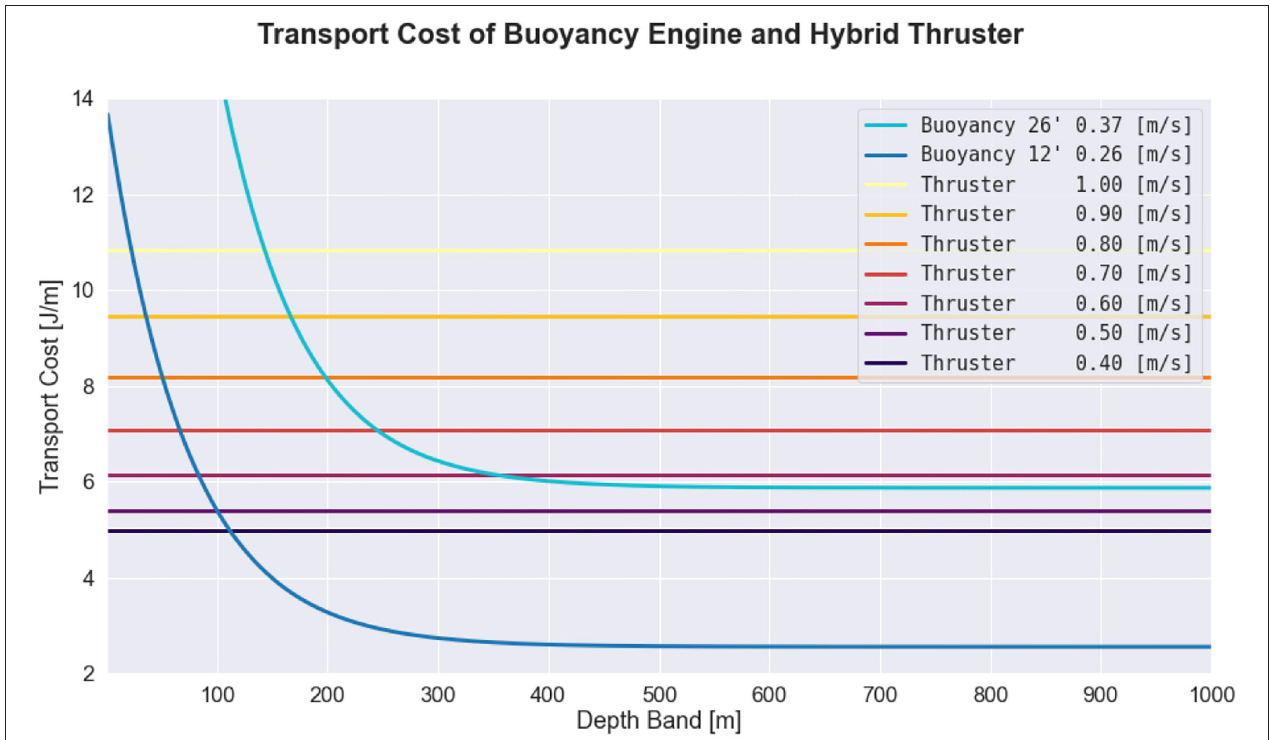
FIGURE 3 | Comparison of transport cost between the buoyancy engine and the thruster when the glider is operating in transit mode, where transport cost is defined as energy expended per horizontal distance traveled. The blue curves correspond to the transport costs of the buoyancy engine at 12 ◦ and 26 ◦ pitch angles, while the yellow, orange, and red curves correspond to the thruster, which is assumed to be traveling at level flight. The average power demand of the buoyancy engine depends on ballast pumped (which is conventionally held constant) and duty cycle (which is dependent on pitch angle and depth band), while the average power demand of the thruster depends only on the thruster speed